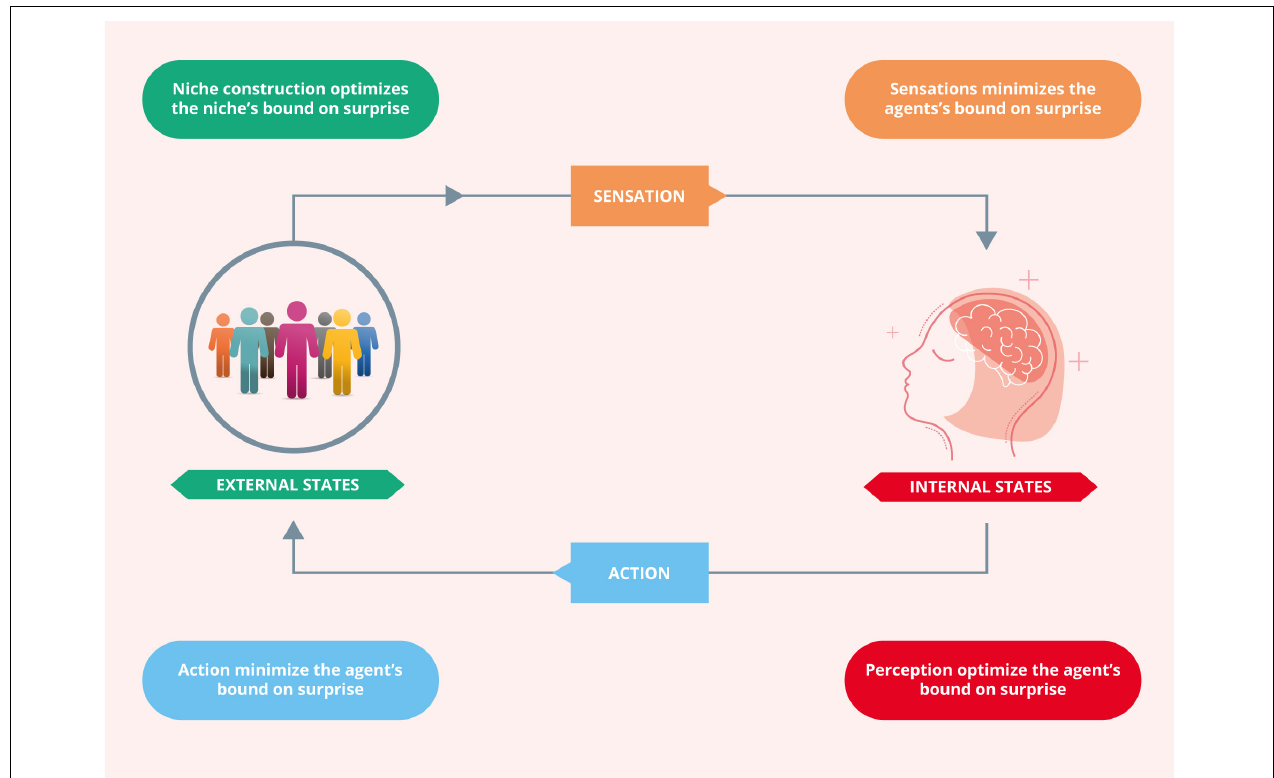
FIGURE 2 | Active inference. This Figure depicts the coupling of an agent’s internal states (the dynamics of which entail predictions or beliefs about the niche) to its external states (the dynamics of the agent’s niche). Adapted with permission from Vasil et al. (2020).